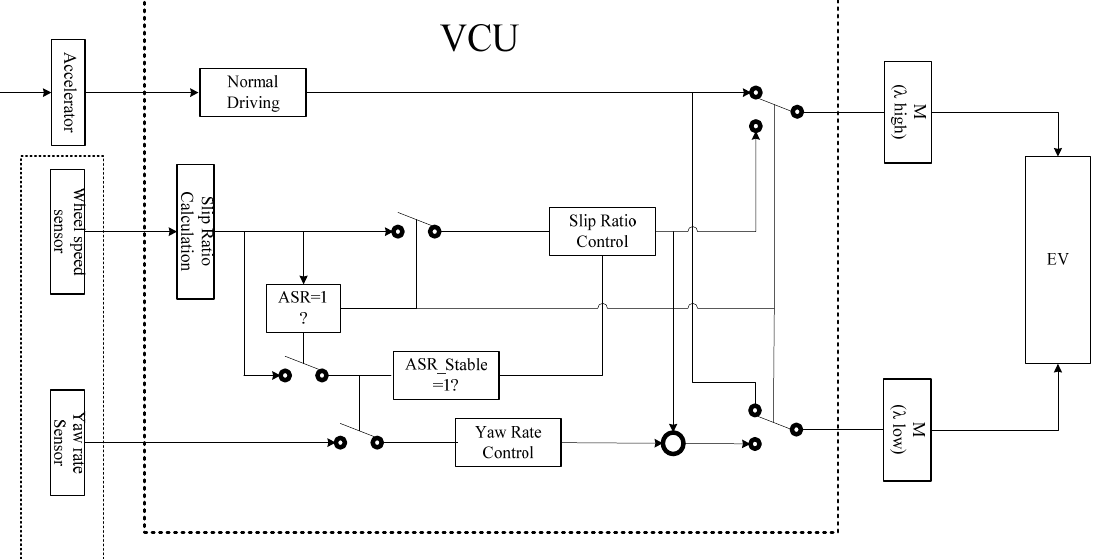
Figure 7. Implementation of acceleration slip regulation